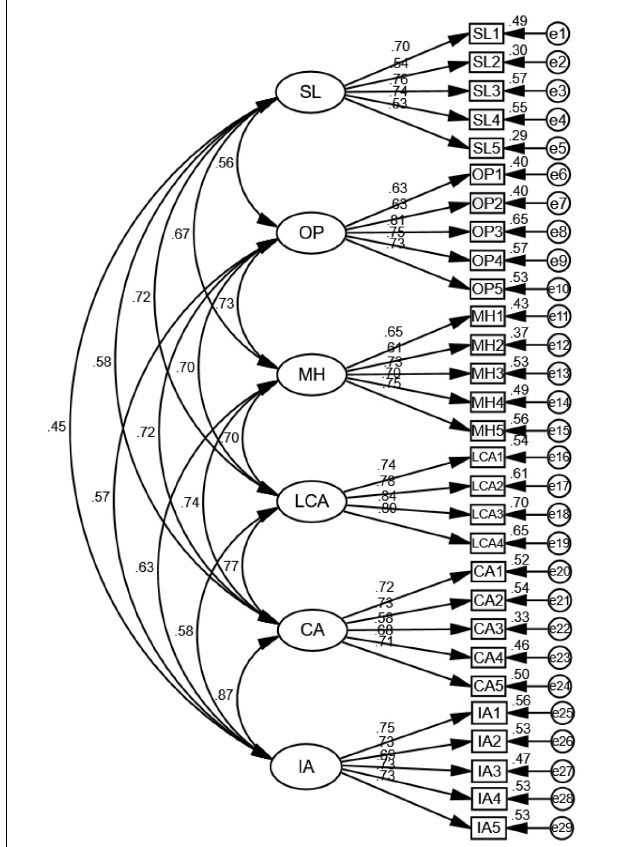
FIGURE 2 | Measurement